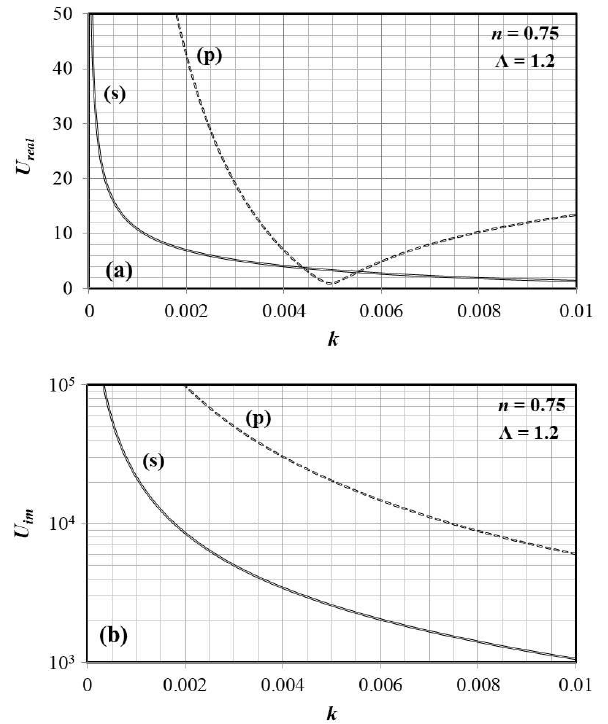
Figure 3. Normalized relative error U real ( a ) and U im ( b ) as a function of k , for both polarisation states. Throughout, we assume constant values for n = 0.75 and Λ =